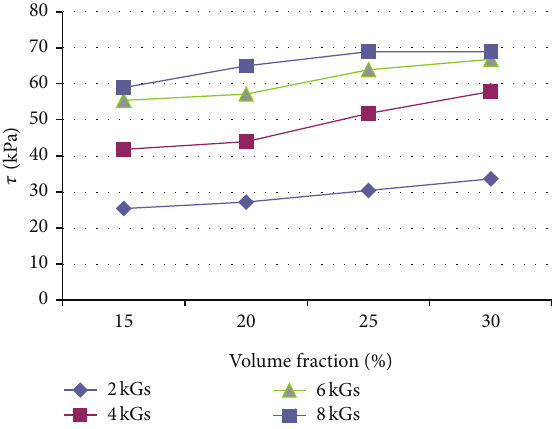
Figure 9: The shear stress of the different magnetic induction intensities. Table 1: The MR fluid samples on different particle volume frac- tions.